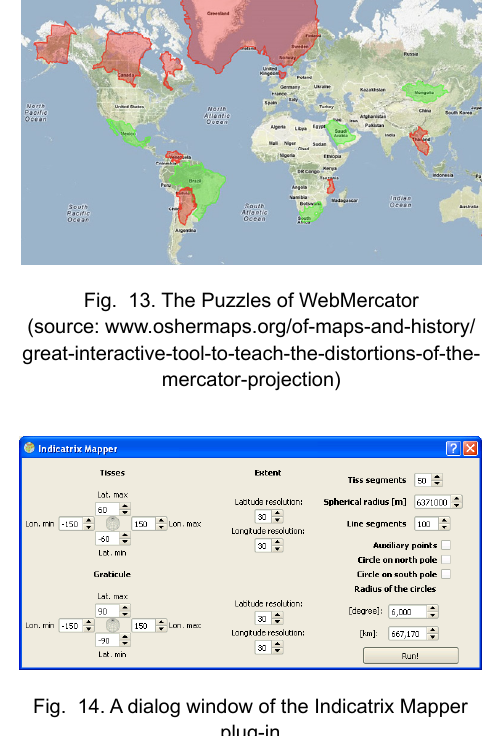
Fig. 14. A dialog window of the Indicatrix Mapper